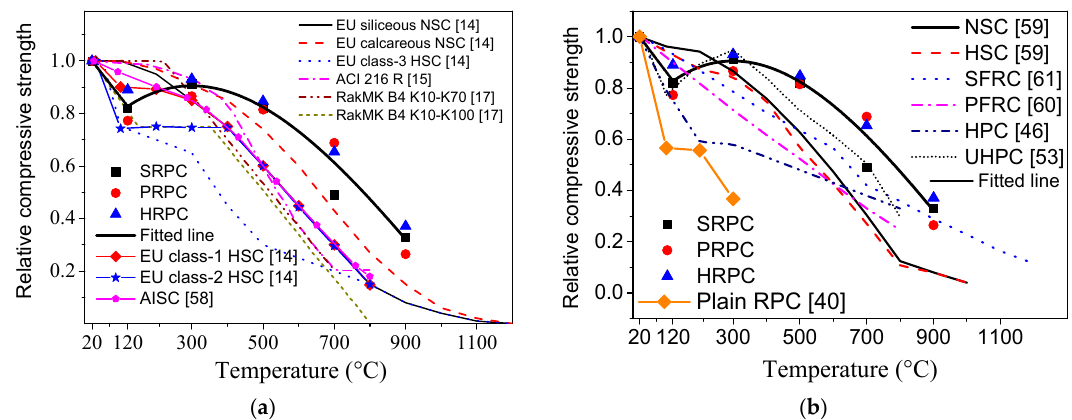
Figure 5. Comparison of the normalized compressive strength of reactive powder concrete (RPC) with ( a ) design codes and ( b ) previous research.